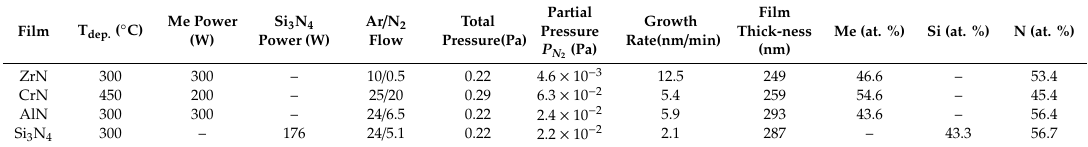
Table 1. Process parameters and chemical analysis for ZrN, CrN, AlN and Si 3 N 4 reference films. Film